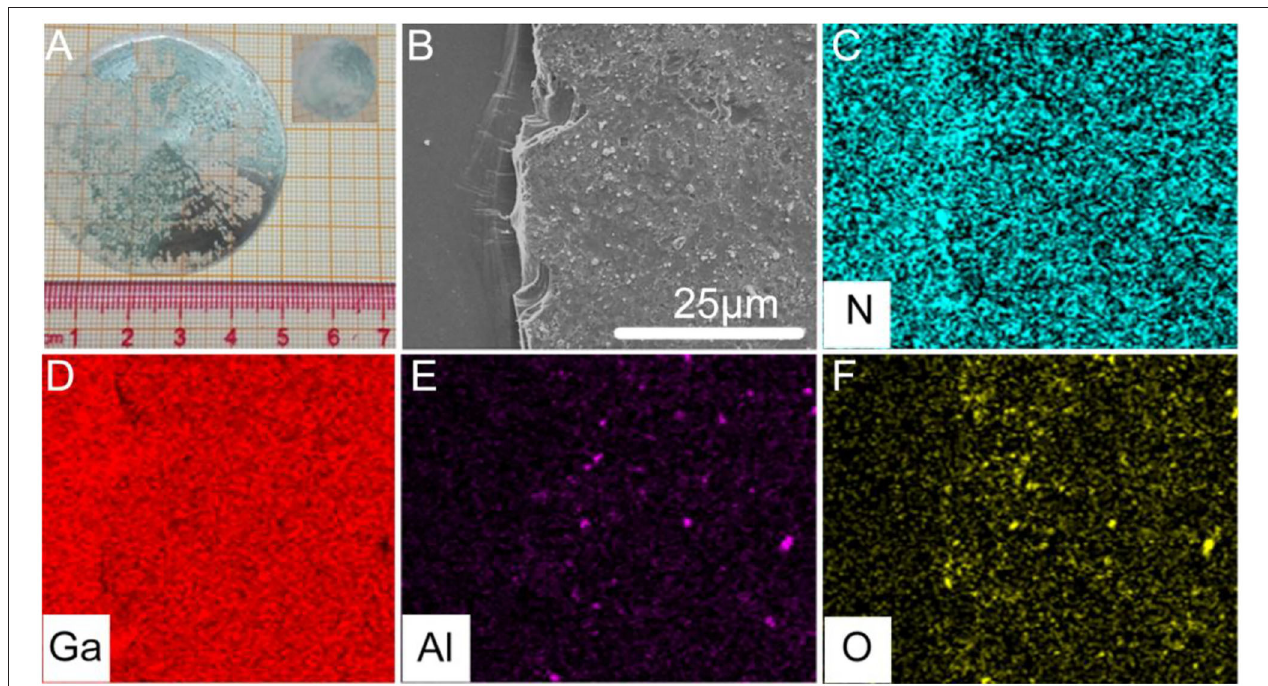
FIGURE 6 | (A) Photographic image of 2-inch free-standing GaN wafer in Figure 5D after the sapphire substrate is removed with LLO. (B) SEM image for local area of insert of (A) after immersion in hot concentrated HCl at 50 ◦ C for 30min. (C–F) EDS mapping analyses for the elements N, Ga, Al, and O in (B) ,